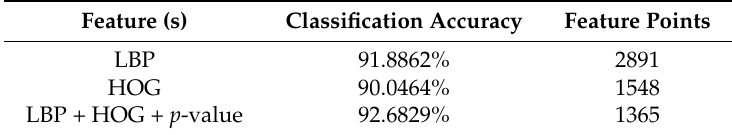
Table 1. Comparison of Gender Classification Accuracy Using Different Features.